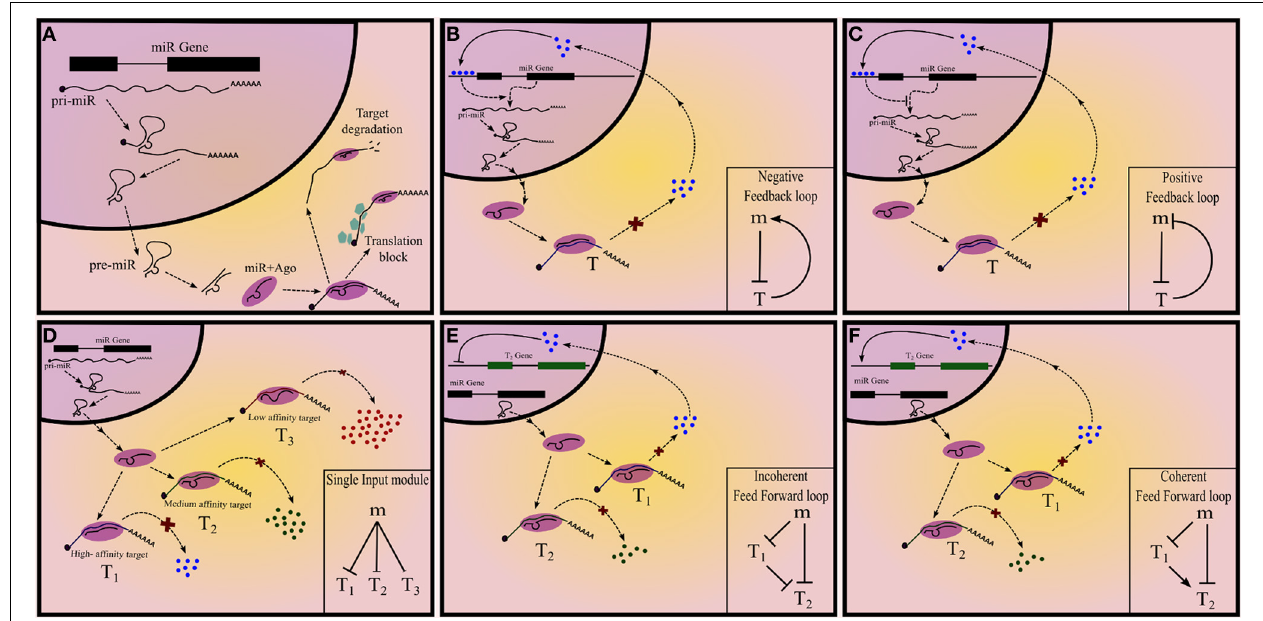
FIGURE 1 | Summary of different types of network motifs in miRNA mediated gene regulatory networks. (A) Summary of miRNA biogenesis and mechanism of action. (B) Positive and (C) negative feedback loops, with a miRNA and a transcription factor. (D) Single